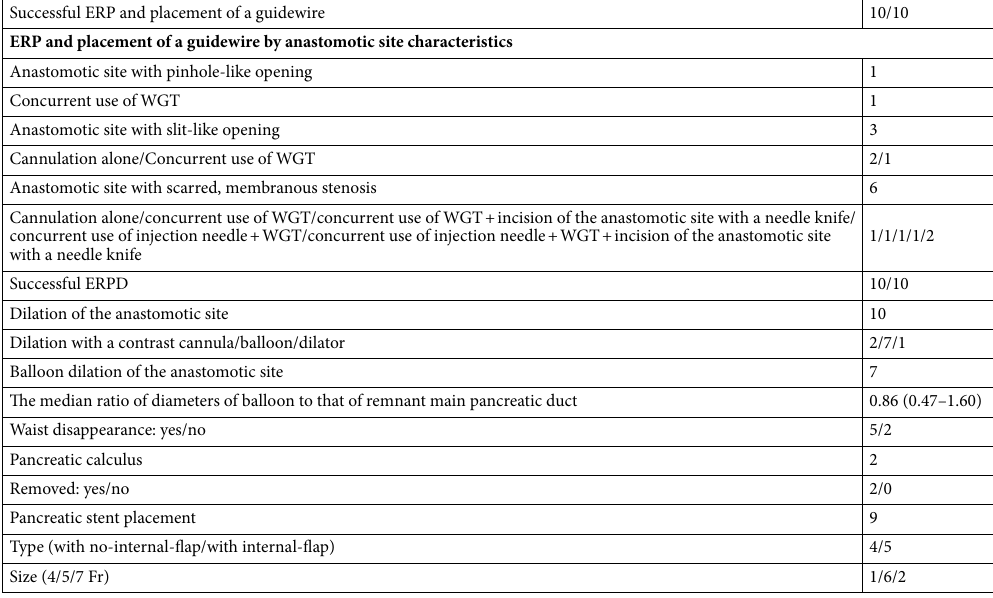
Table 3. ERPD. ERPD endoscopic retrograde pancreatic drainage, ERP endoscopic retrograde pancreatography, WGT wire-guided technique.